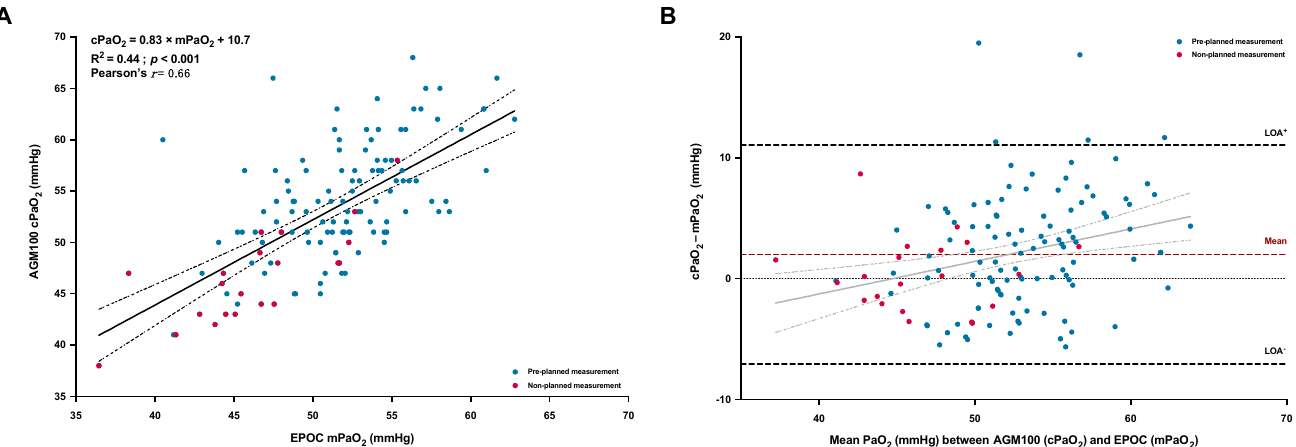
Figure 1. Linear regression and correlation ( A ) between the measured arterial PaO 2 (mPaO 2 ) with the portable blood gas analyzer (EPOC) and the calculated PaO 2 (cPaO 2 ) provided by the AGM100 device; the solid and dashed lines represent the regression line with the 95% confident interval limits. Bland–Altman plot of agreement ( B ) between the cPaO 2 and the mPaO 2 , expressed as absolute differences vs. the mean of both measurements; the dashed lines represent the mean bias (in red) and the 95% limits of agreement (LOA, in black). Individual values were identified as pre-planned measurement (early morning after a first night at high altitude, blue solid circles) or as non-planned measurement (occurrence of an early altitude-related adverse health effect, red solid circles). Table 2. Agreement among parameters derived from the AGM100 and EPOC devices.